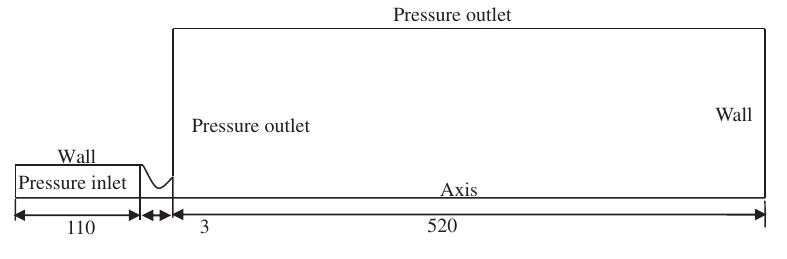
Figure 2: Geometry of computational region.